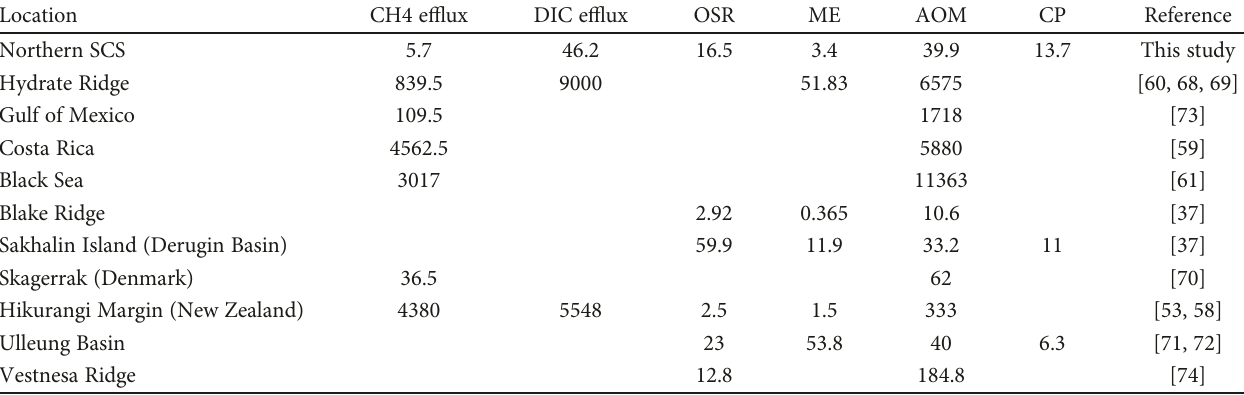
Table 2: Areal comparison of biogeochemical rates and e ffl uxes of methane and DIC with other cold